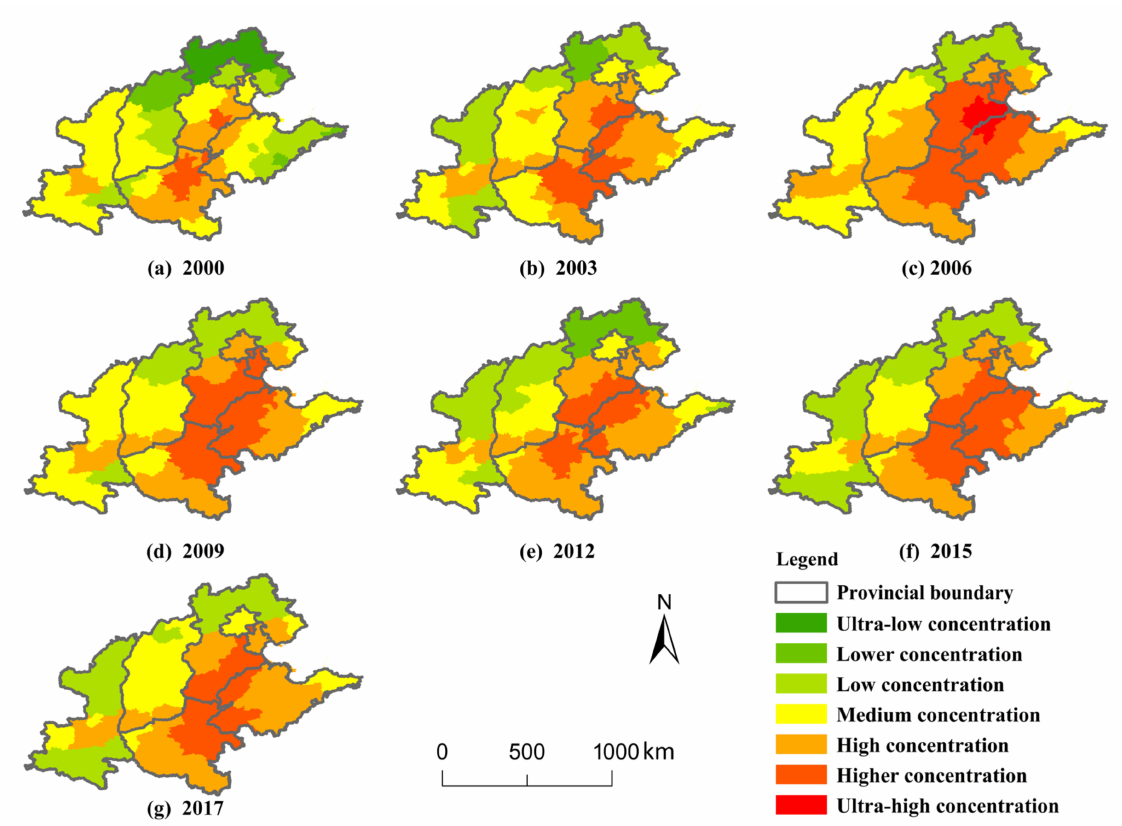
Figure 6. Spatial distribution features of PM 2.5 concentrations in major years